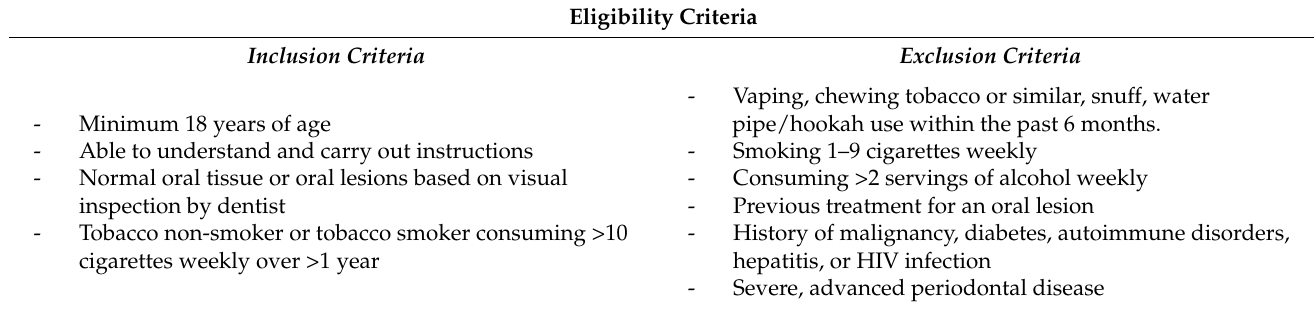
Table 1. Recruitment inclusion/exclusion